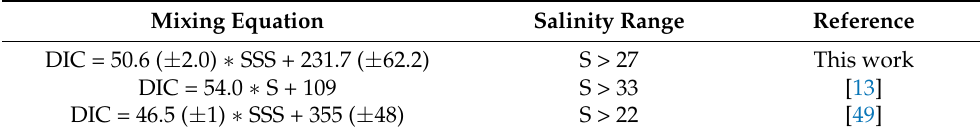
Table 3. Mixing equations, including Equation (4), between the Congo River and oceanic waters. Mixing Equation Salinity